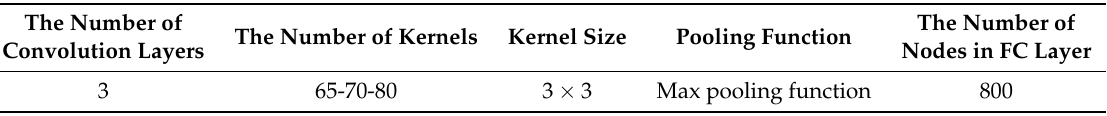
Table 4. The architecture parameters of the proposed convolutional neural network (CNN) recognition model for the pasting